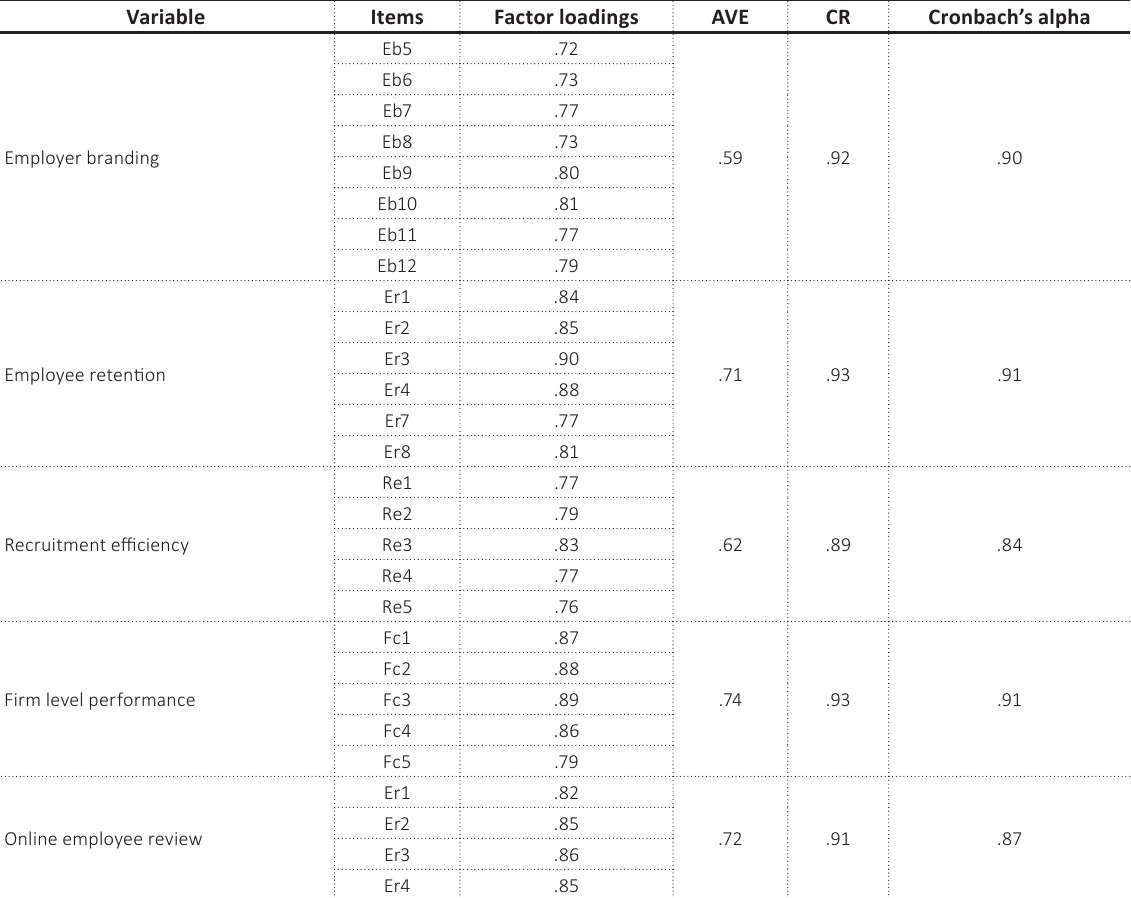
Table 2. Reliability and